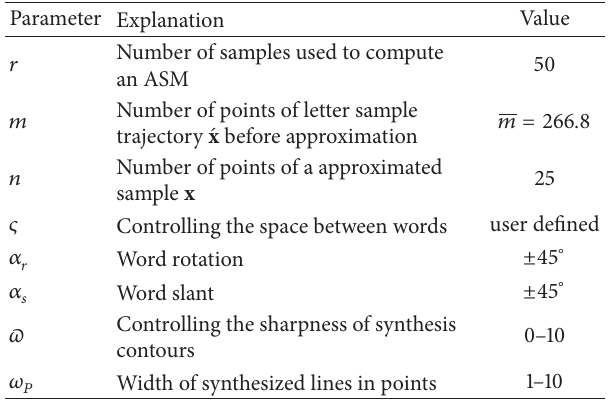
Table 2: Parameters and